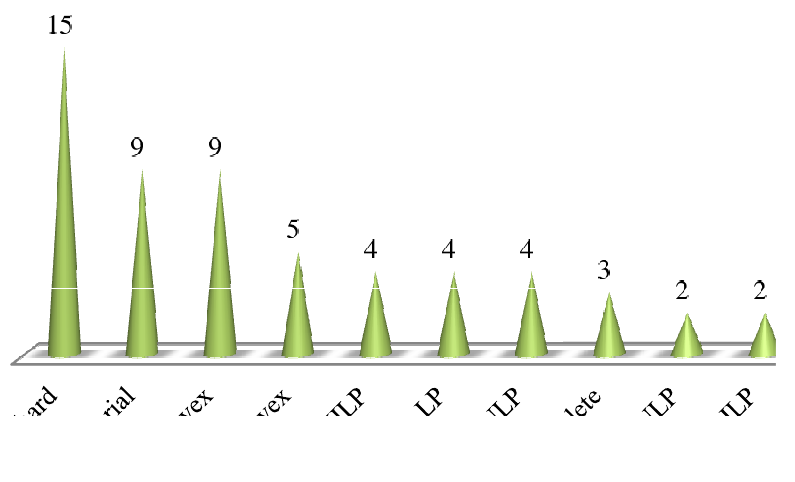
Figure 8. Trend of research community w.r.t. nature of Multi-objective Optimization (MOO)